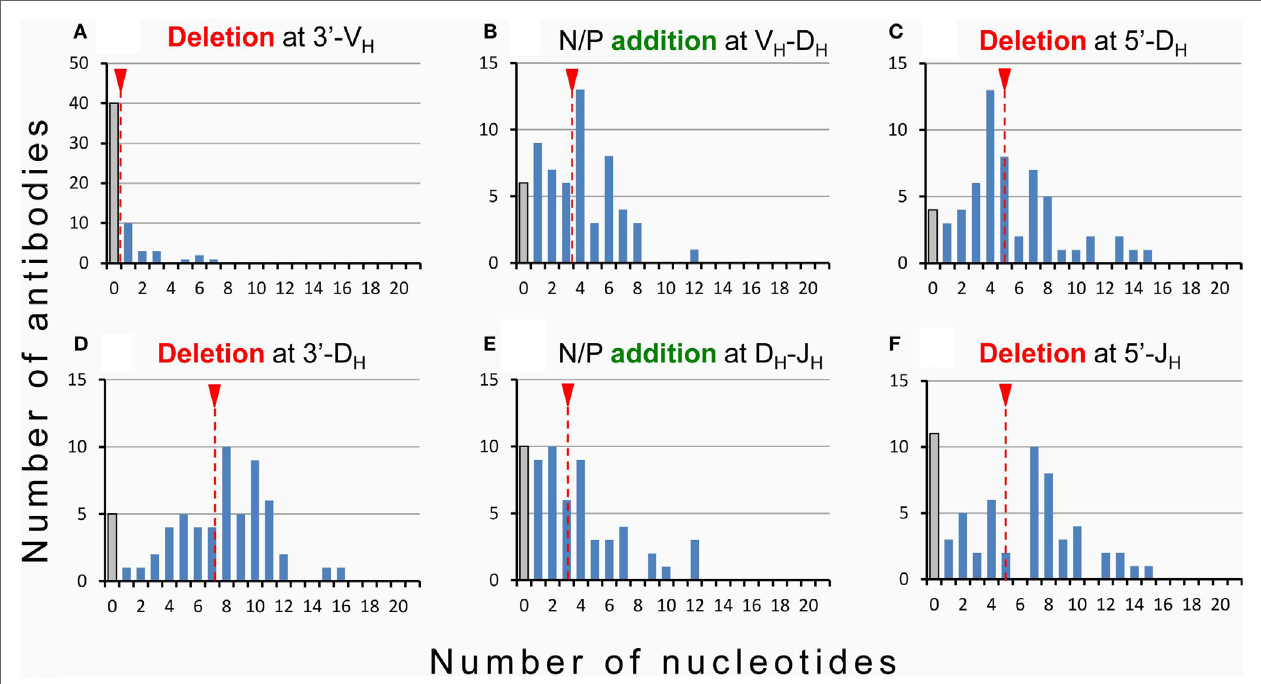
FiGURe 3 | Modification of VDJ gene segments in anti-hapten antibodies. Homozygous mutant mice containing a single frameshifted DFL16.1 D gene segment ( Δ D-D μ FS mice derived from BALB/c mice) were immunized with the hapten 2-phenyl-oxazolone (phOx) coupled to chicken serum albumin (87). Monoclonal antibodies ( n = 83) were prepared during various stages of primary and memory responses and V region sequences were determined (87). Fifty-eight (~70%) used modified D H gene sequences and two mAb (~2.5%) reverse D H sequences. Nucleotide deletion and addition of N/P nucleotides is shown for these two groups of antibodies: (A) nucleotide deletion at 3 ′ -V H , (B) addition of N/P nucleotides at the V H -D H junction, (C) nucleotide deletion at 5 ′ -D H , (D) nucleotide deletion at 3 ′ -D H , (e) addition of N/P nucleotides at the D H -J H junction, and (F) deletion of nucleotides at 5 ′ -J H . The medium values of deletion and addition are indicated by broken red lines with a red triangle on top. Antibodies using the genomic configuration at a particular site are represented by gray bars. In 23 additional mAb (~28%), the D H coding sequence was truncated by exonuclease activity to such an extent that it could not be